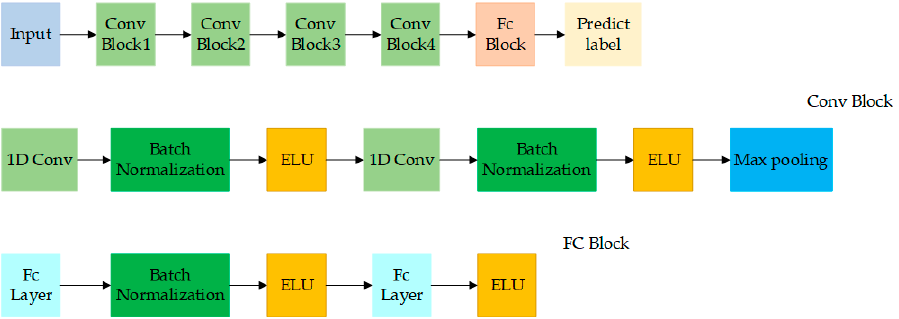
Figure 5. The structure of DCNN based on full wavelengths.